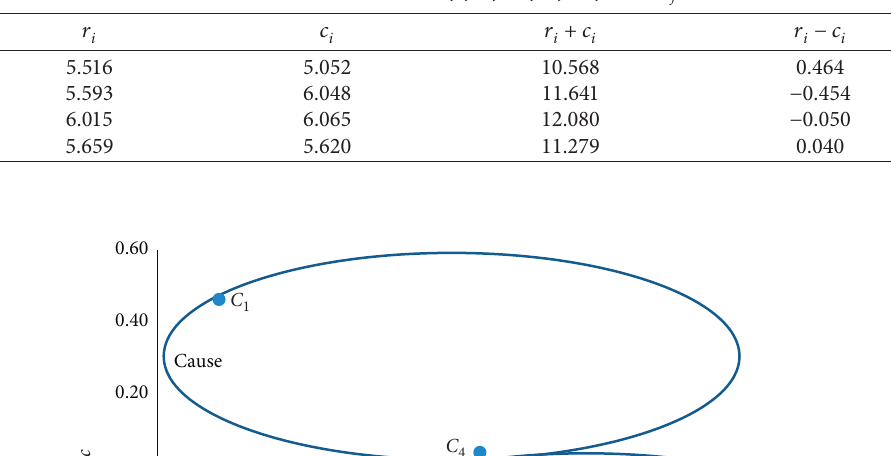
Figure 1: Influence relation diagram between criteria. Table 5: Values of r